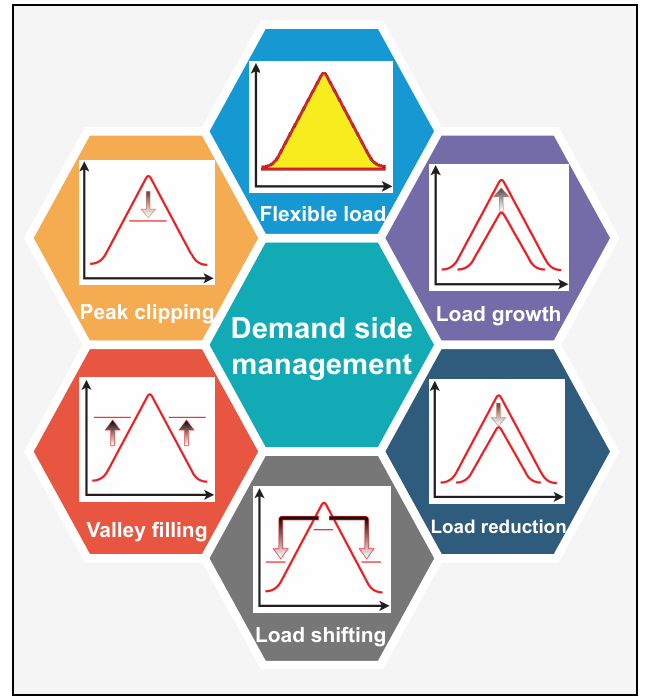
Figure 3. Demand-side management techniques